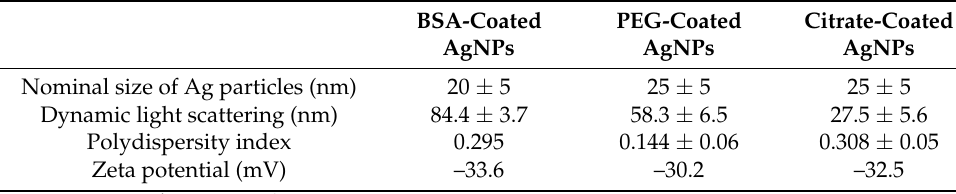
BSA-Coated PEG-Coated Citrate-Coated AgNPs AgNPs AgNPs